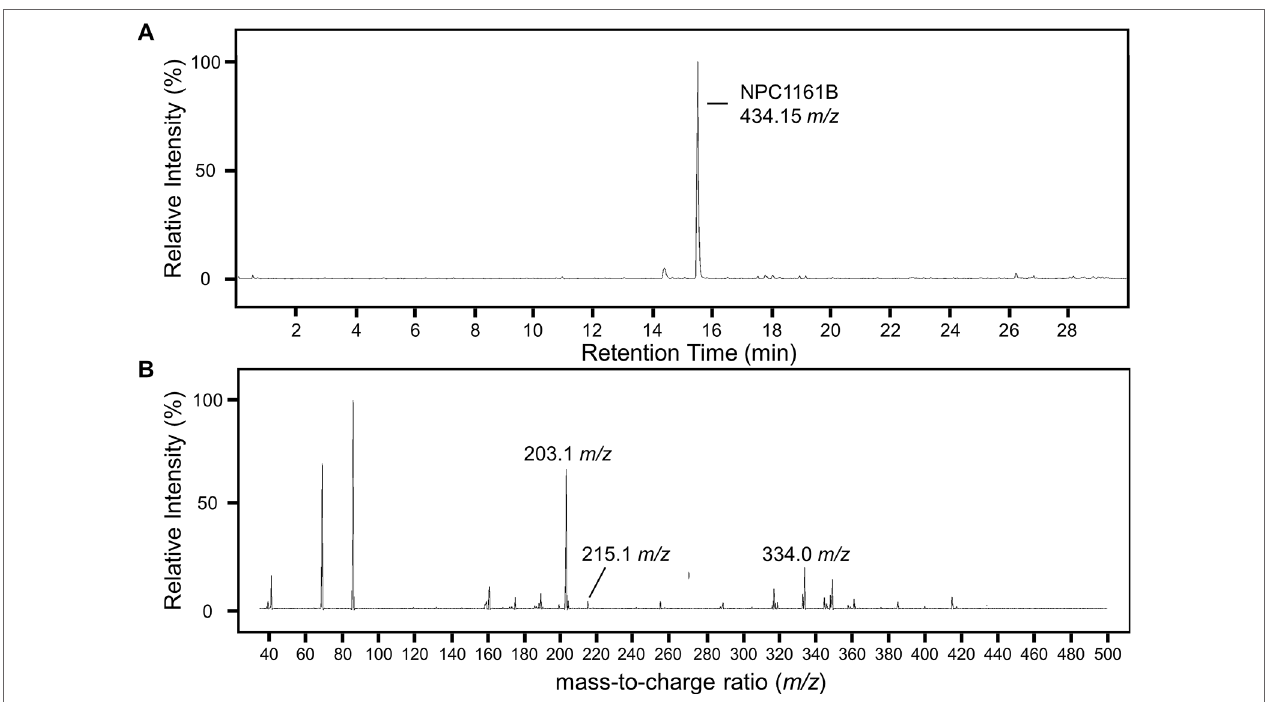
FIGURE 3 | Analysis of NPC1161B standard by LC-QqQ-MS. Extracted ion chromatogram for NPC1161B standard (A) and the resulting product ion scan (B) . Product ion scanning was used to select fragment ions of NPC1161B for downstream precursor ion scanning to determine metabolites of NPC1161B extracted